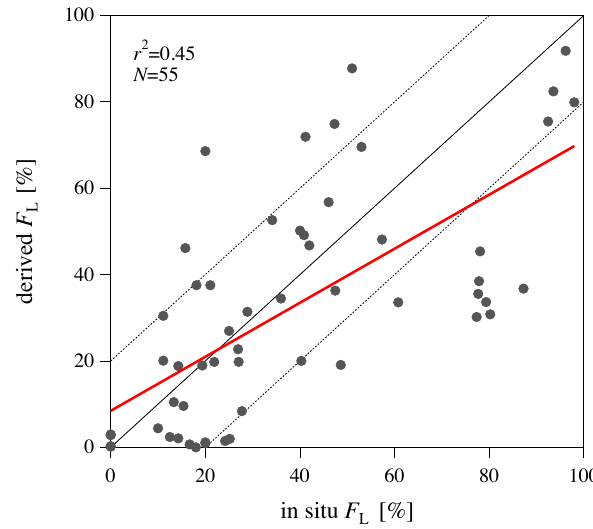
Fig. 3. Comparison of SDM-derived F L and in situ F L ( r 2 = 0.45, p < 0.0001, RMSE = 22.7, N = 55). Solid red line represents the regression line (slope = 0.63, intercept = 8.46), the solid black line indicates the 1:1 line, and the dashed lines indicate the +/-20% F L range with respect to the 1:1 line. 38 out of 55 validated data are correctly derived within +/-20% F L range (success rate of 69%).